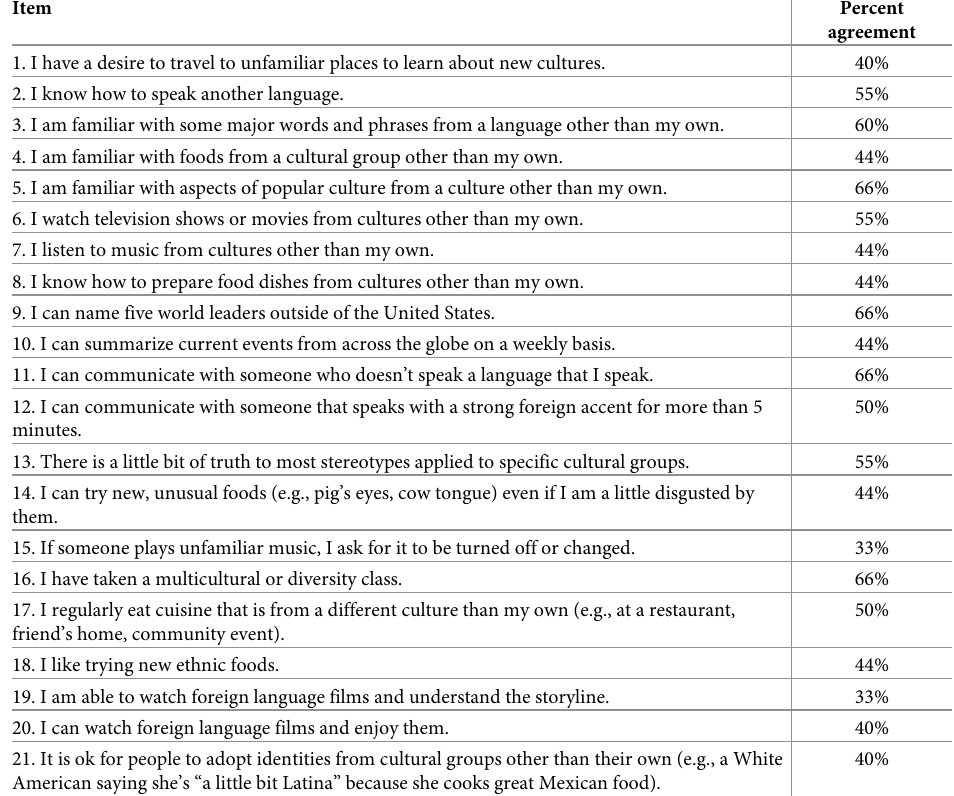
Table 2. Items eliminated by first expert panel.